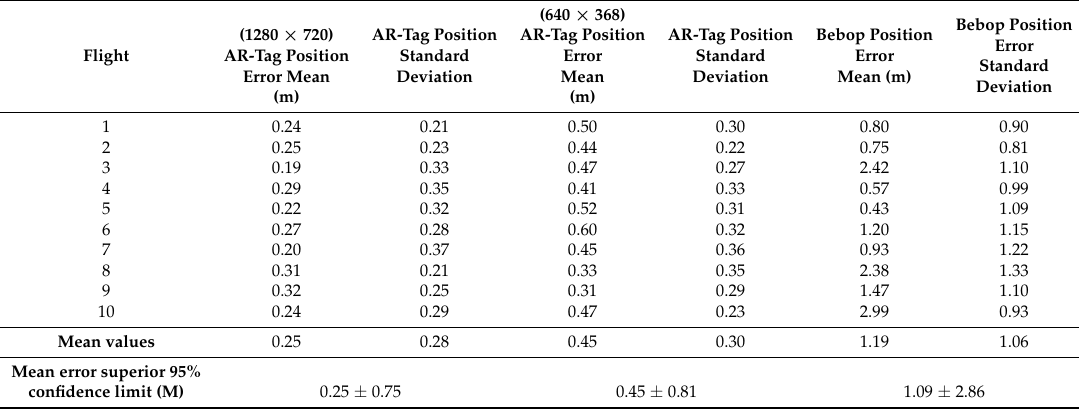
Table 4. Horizontal absolute error measurement statistics: AR-Tag × Bebop odometry. (1280 × 720) AR-Tag Position AR-Tag Position Flight